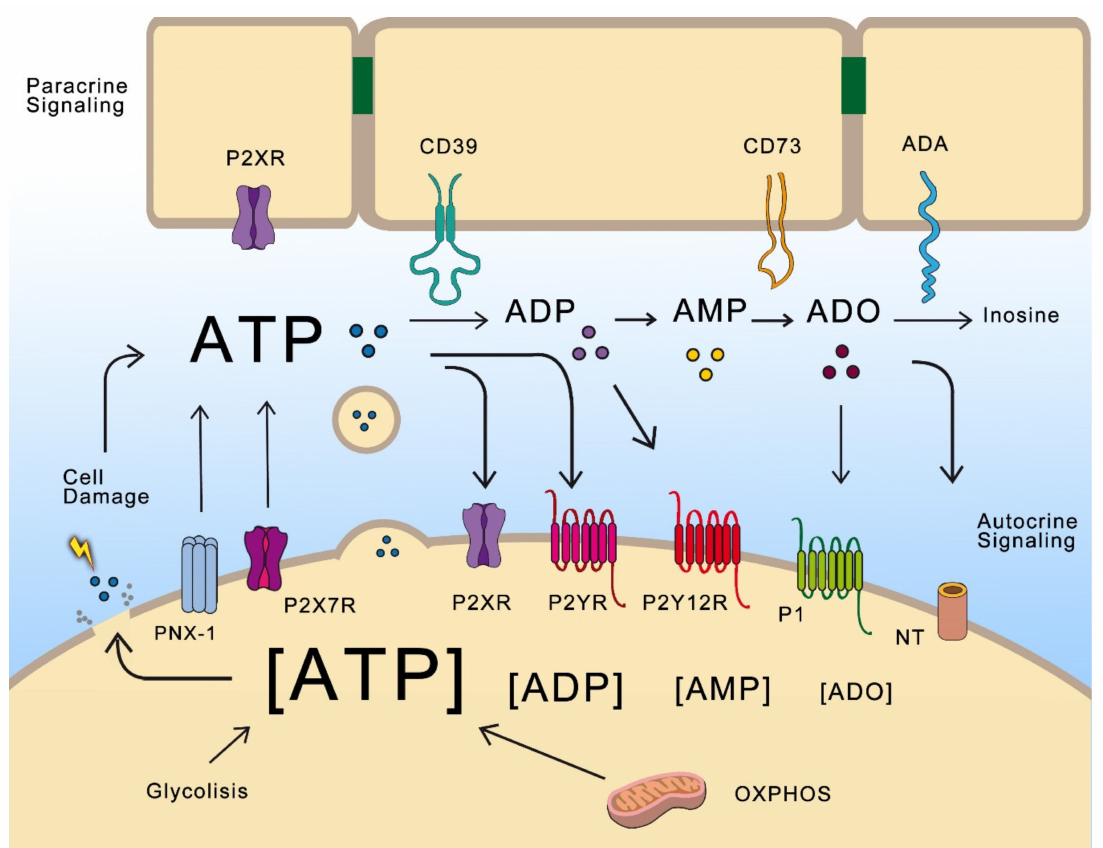
Figure 1. Nucleotides act as autocrine and paracrine messengers. ATP is produced by oxidative phosphorylation (OXPHOS) and glycolysis intracellularly reaching mM concentrations. It can be released to extracellular space by cellular lysis, exocytosis, transporters, hemichannels of pannexin-1 (PNX-1) and P2X7R. Once located at the extracellular space, ATP activates P2XR (ligand activated ion channels), P2YR receptors (belonging to GPCR superfamily), and it can be hydrolyzed by ectonucleotidases (here, CD39 and CD73 are illustrated by their relevance in cancer) to form ADP, AMP and adenosine (ADO). ADP is able to activate P2Y12R and ADO activate G-protein coupled receptor (GPCR) receptors of the P1 family named (A1R, A2AR, A2BR and A3R). ADO is hydrolyzed